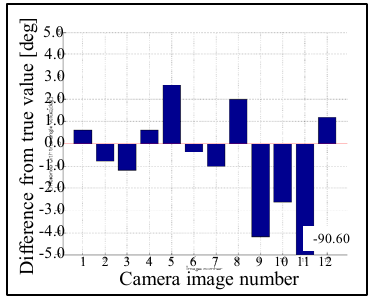
Figure 13. Estimated azimuth angles in the 3-DOF (wide range)